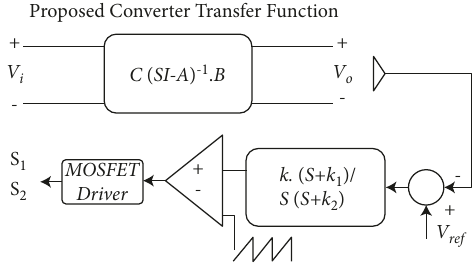
Figure 10: Control scheme for the proposed converter.